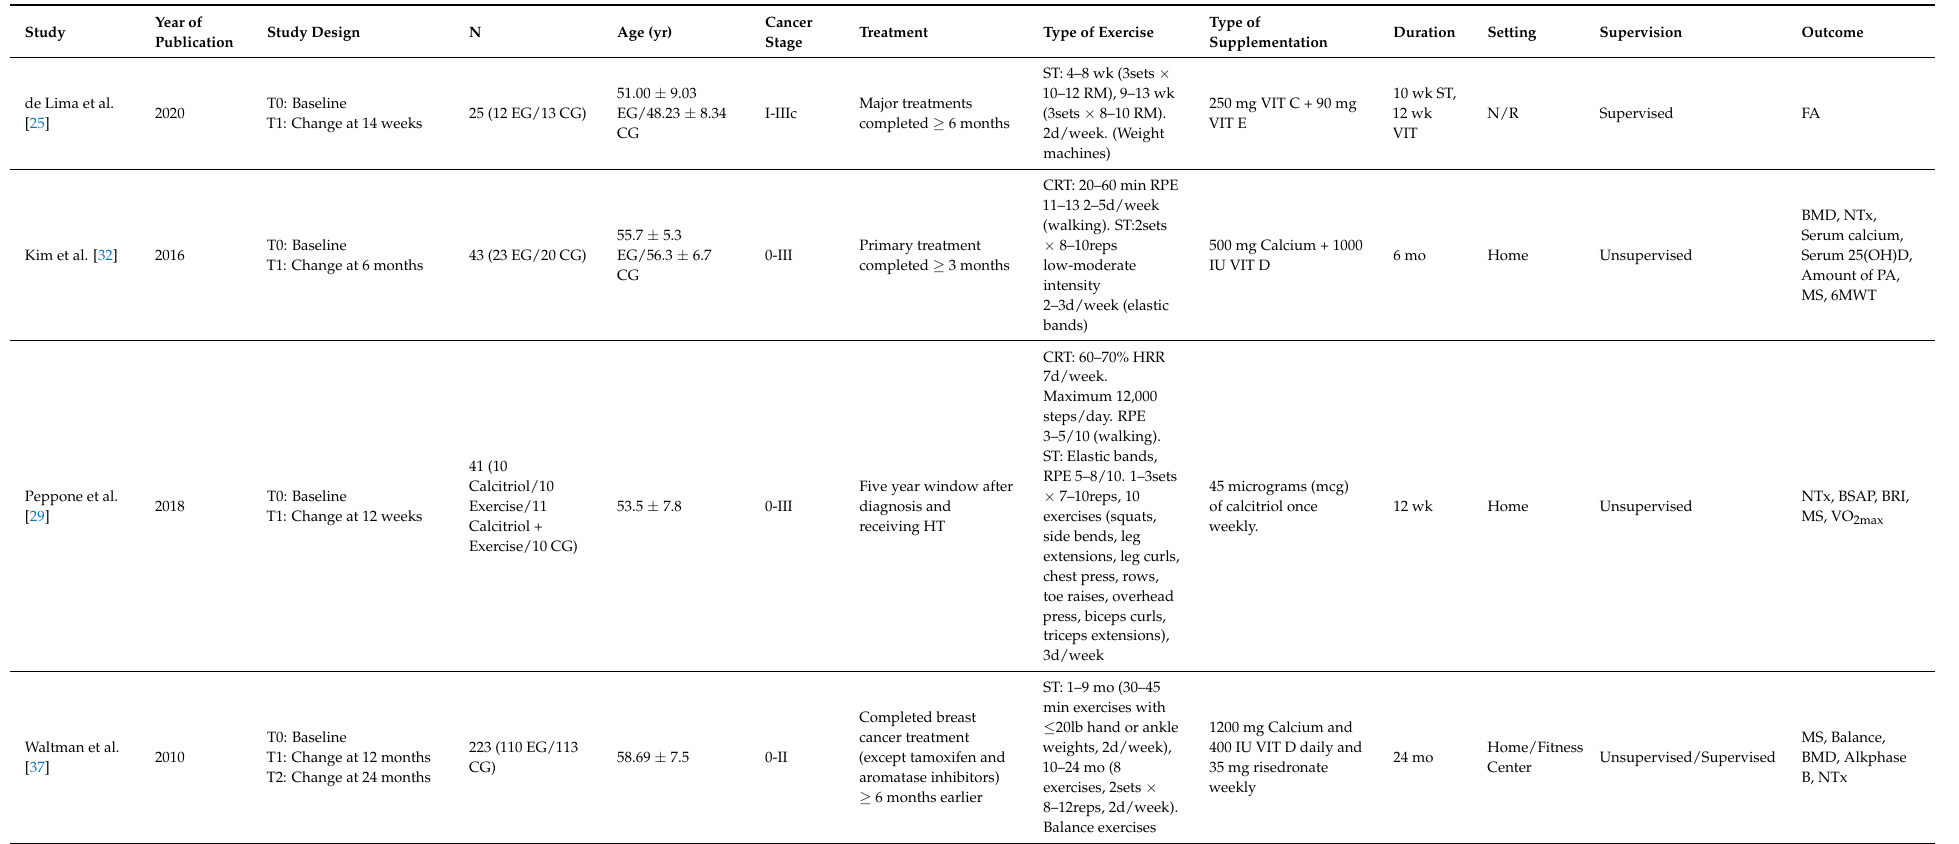
Table 2. Characteristics of studies with exercise plus supplementation